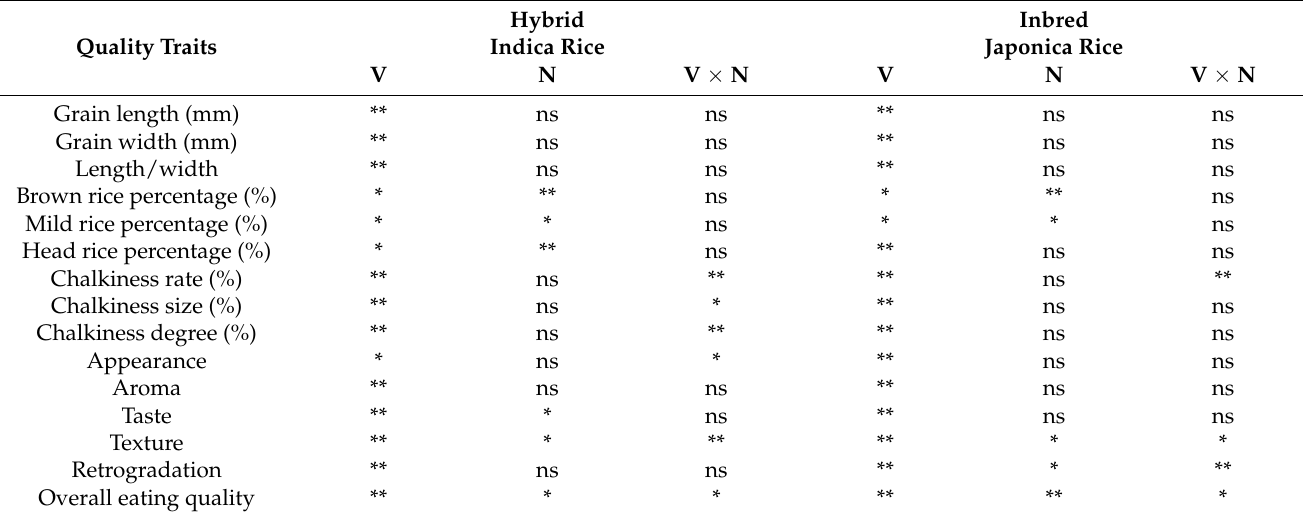
Table 1. Significance of variance estimates related to varieties, nitrogen levels, and their interactions on grain